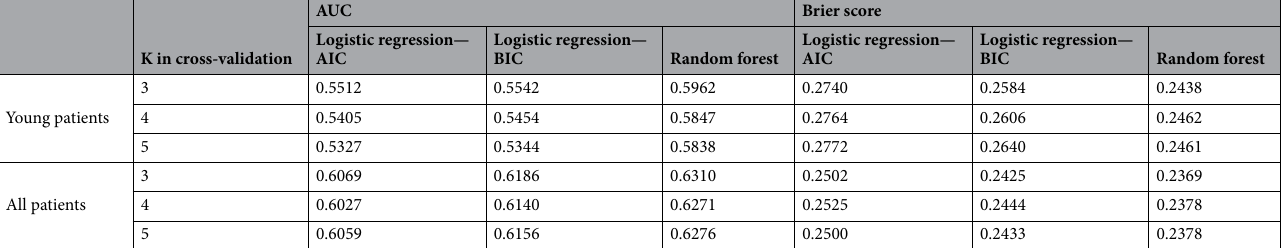
Table 5. Performances of the models measured using stratified K-fold cross-validation. For each value of K, the stratified K-fold cross-validation was repeated twenty times and the results averaged. Higher values of the AUC and smaller values of the Brier score are